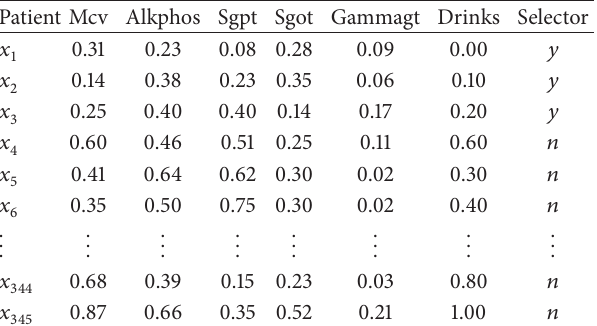
Table 1: An example of numeric decision system ( Liver